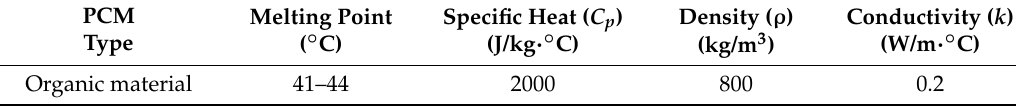
Table 2. The thermal characteristics of the PCM with the melting point of 44 ◦